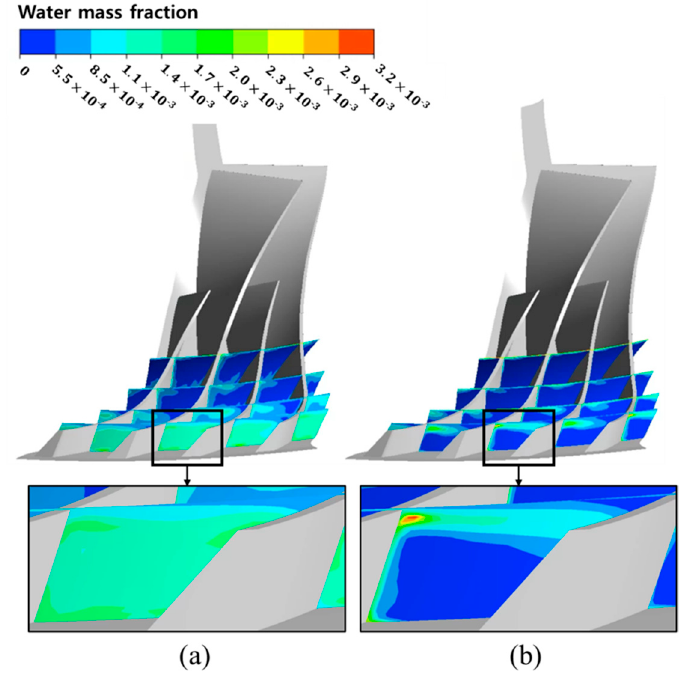
Figure 11. Comparison results of the mass fraction for the case of droplet diameter; ( a ) d r = 2 µ m and ( b ) d r = 6 μ m.